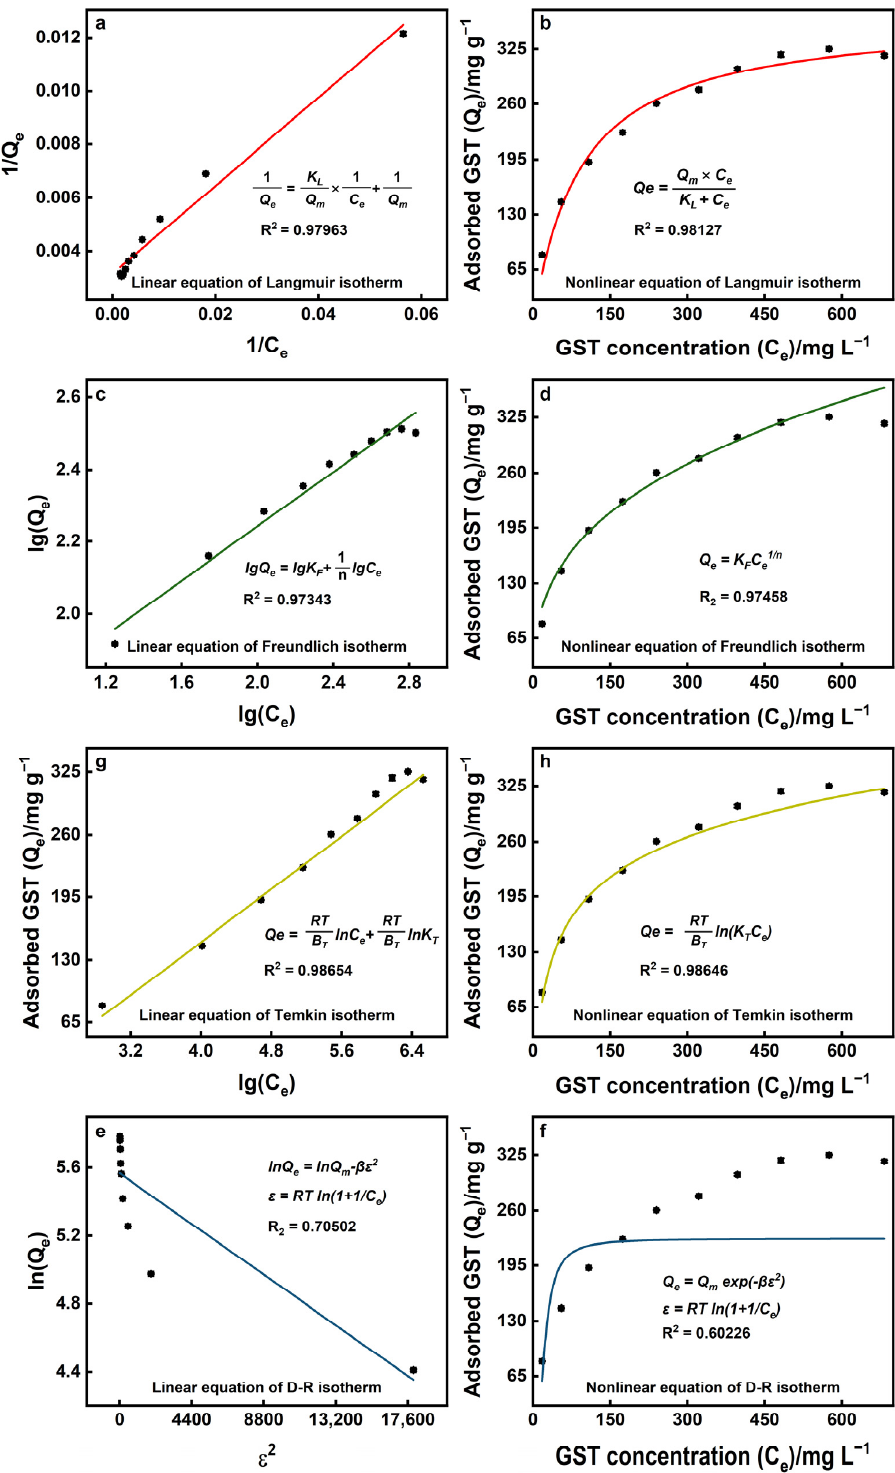
Figure 5. ( a ) The linear fit results of Langmuir isotherm model. ( b ) The nonlinear fit results of Langmuir isotherm model. ( c ) The linear fit results of Freundlich isotherm model. ( d ) The nonlinear fit results of Freundlich isotherm model. ( e ) The linear fit results of Temkin isotherm model. ( f ) The nonlinear fit results of Temkin isotherm model. ( g ) The linear fit results of Dubinin–Radushkevich isotherm model. ( h ) The nonlinear fit results of Dubinin–Radushkevich isotherm model. GST solutions: 100–1000 mg L − 1 and 1.0 mL; mass of the adsorbent: 1.0 mg; adsorption time: 30 min.